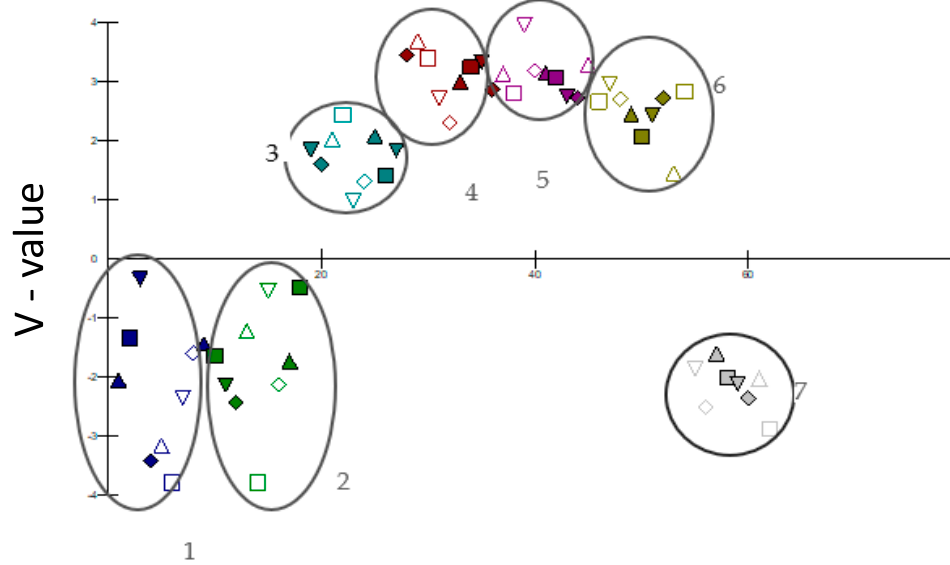
Figure 6. Diagram of V-statistic of all 63 plots. All nine plots of each habitat type are within each